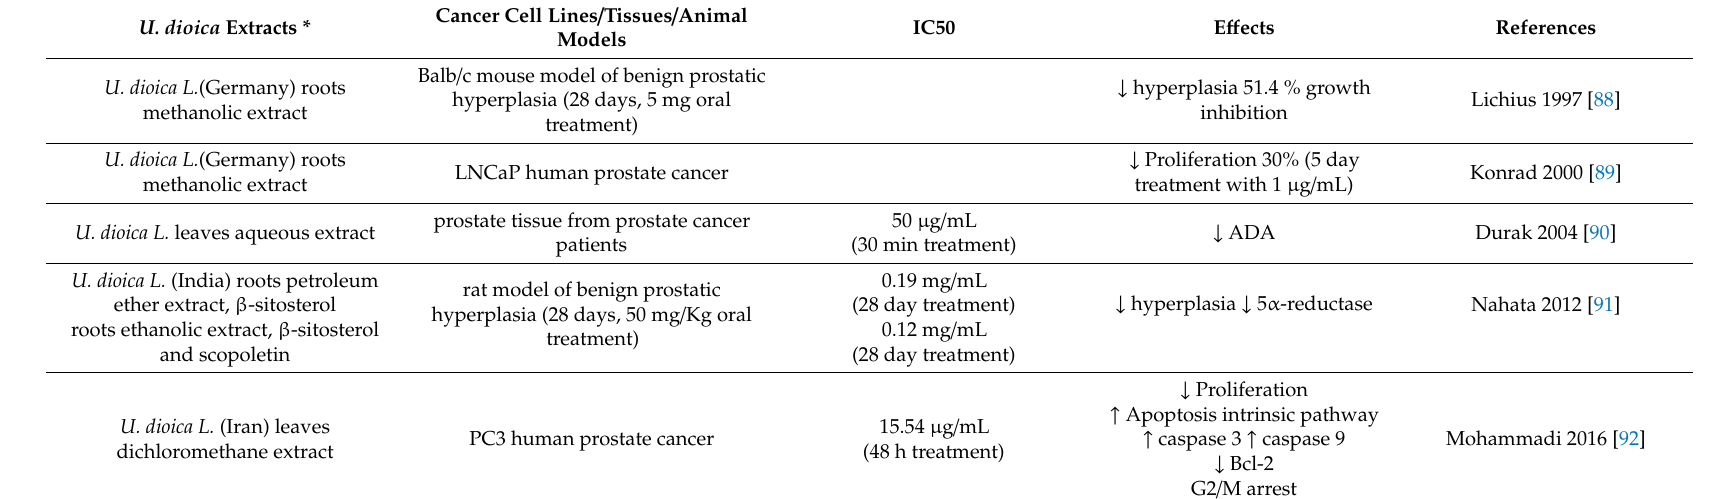
Table 2. Anti-cancer e ff ects of U. dioica : prostate cancer, in-vitro and in-vivo